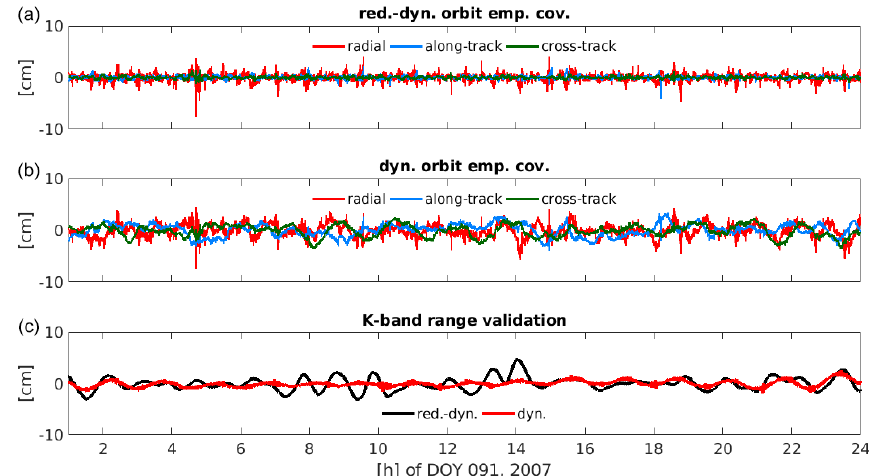
Figure 9. Orbit residuals for day 091, 2007, of GRACE-A using empirical covariances derived for a correlation length of 50min averaged over April 2007 for the reduced-dynamic orbit (a) , the dynamic orbit (b) and the respective K-band range validation (c)